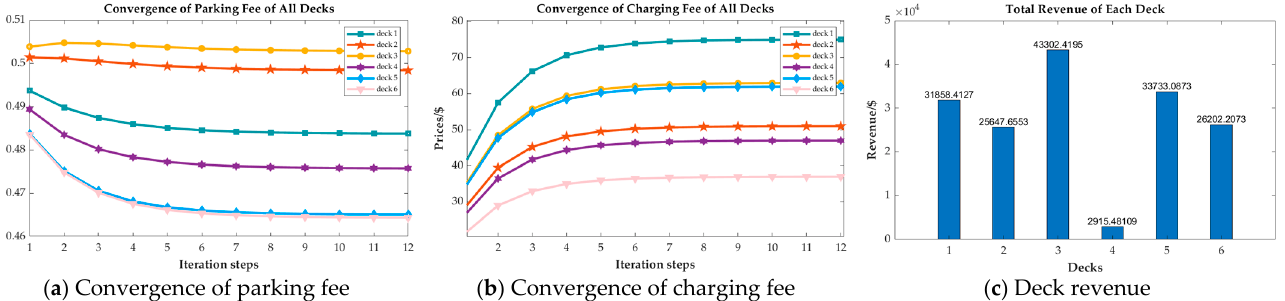
Figure 5. The charging price, parking fee, and total revenue after the number of LSC customers in deck 6 was reduced to zero.